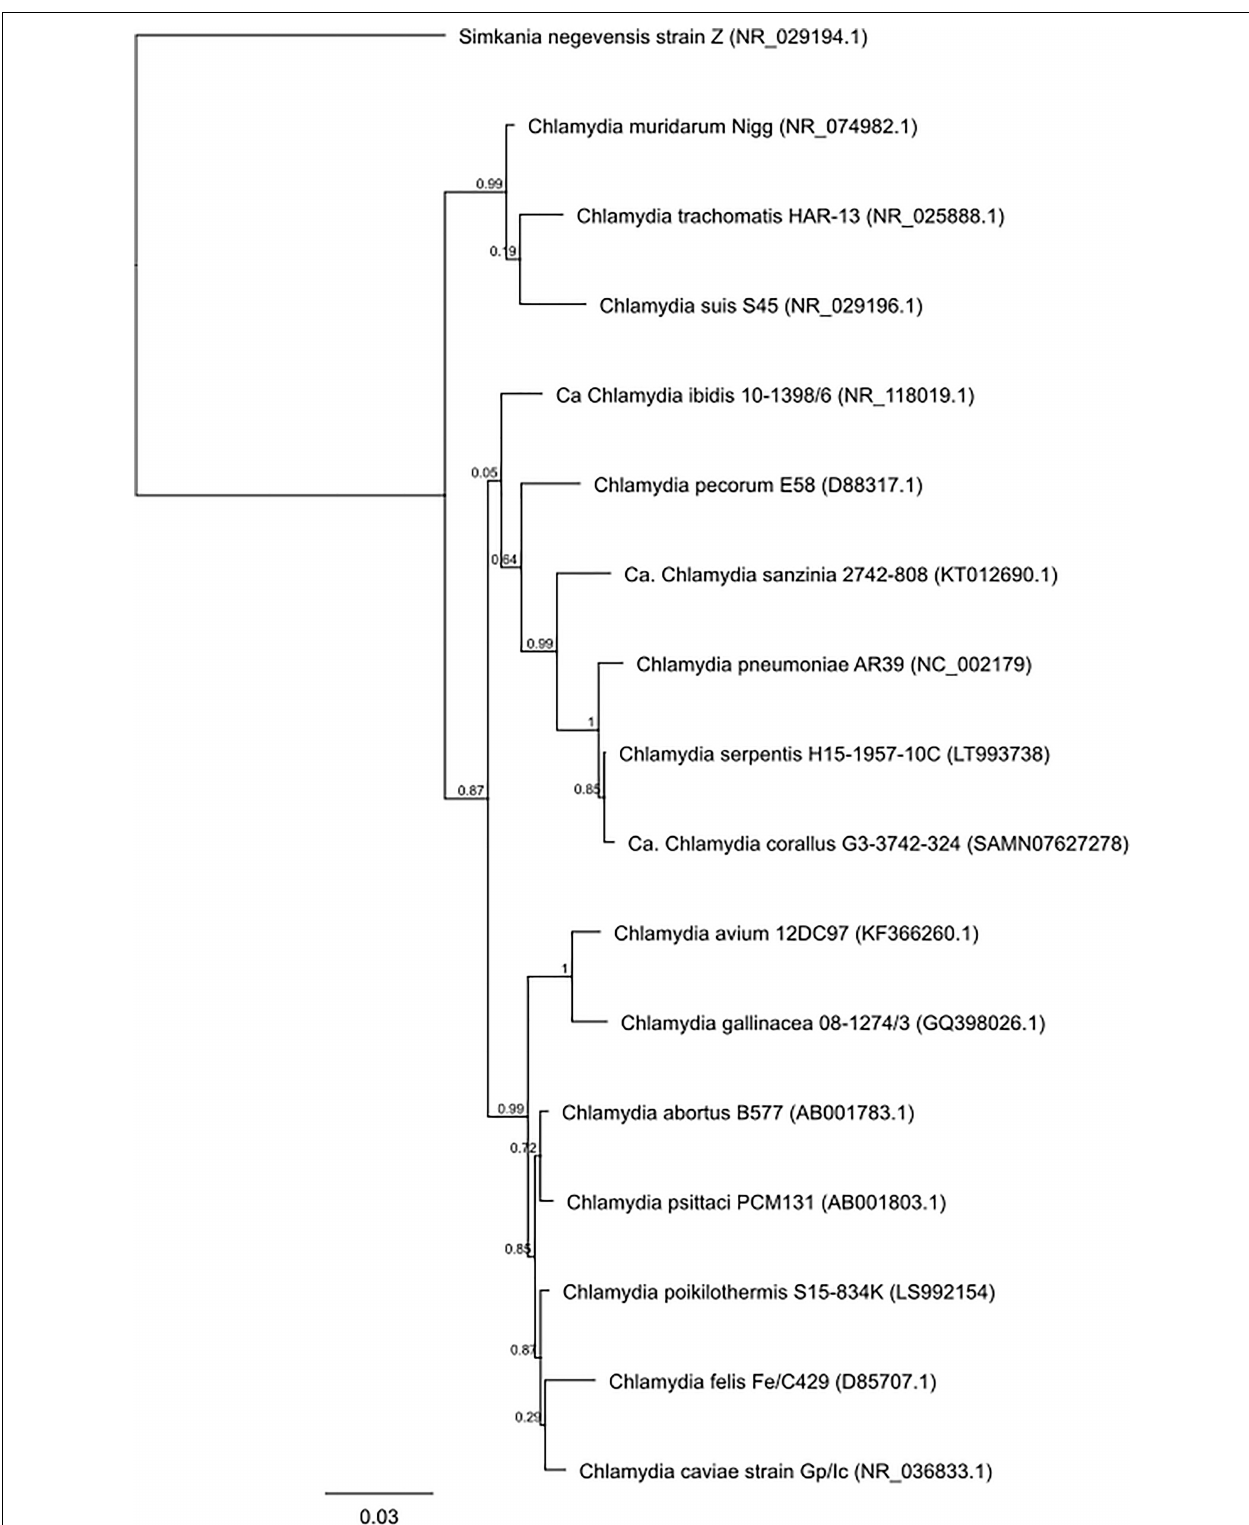
FIGURE 1 | Phylogenetic tree analysis of the family Chlamydiaceae. Approximate likelihood phylogenetic tree analysis, MAFFT alignment of NCBI (Genbank) 16S sequences (1,587 bp) assembled using Geneious v 11.1.4.